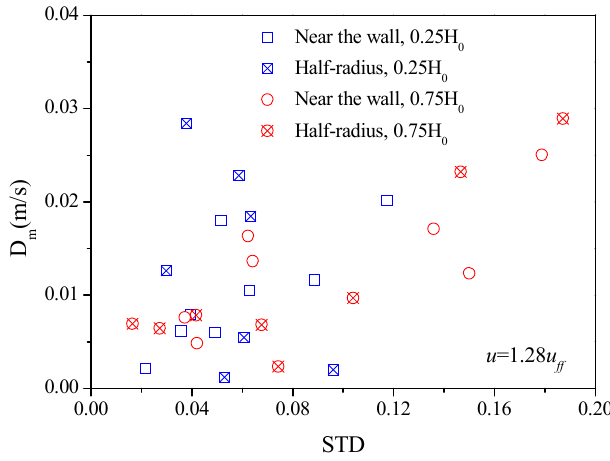
Figure 9. The variations of micro lateral dispersion coefficient of particles with STD at different lateral positions and bed heights when uf = 1.28 u ff .